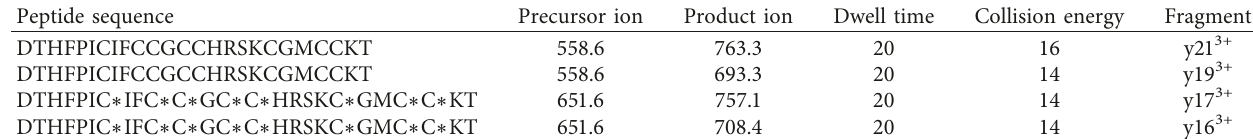
Table 2: A transition list for SRM assay of each of the hepcidin-I and -M containing precursor ion, product ion, and CE values. Peptide sequence HRSKC